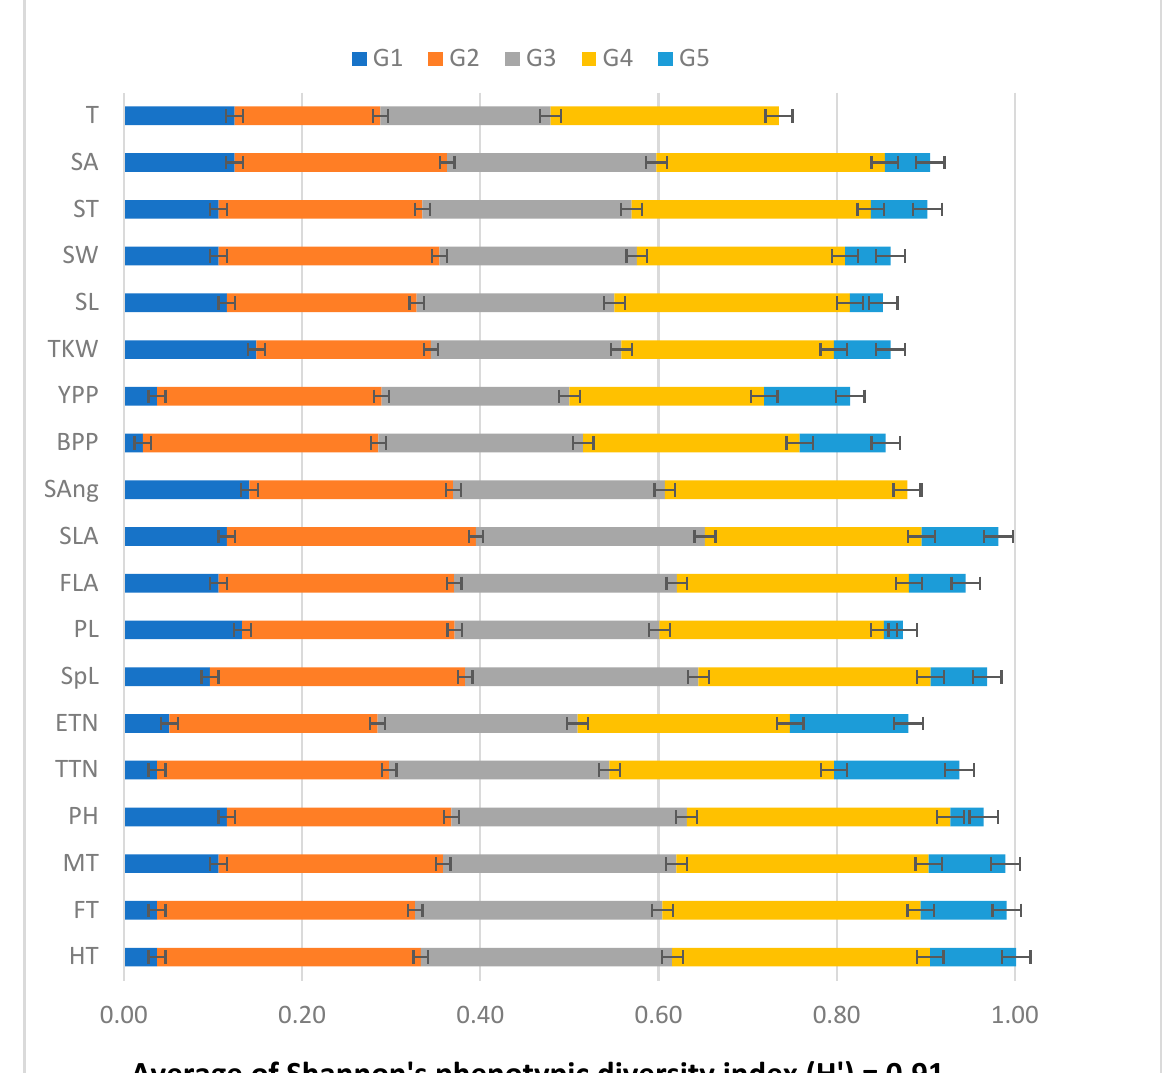
Figure 3. Graphical presentation of Shannon’s diversity index (H) based on each studied trait. Error bar denotes mean ± SD.